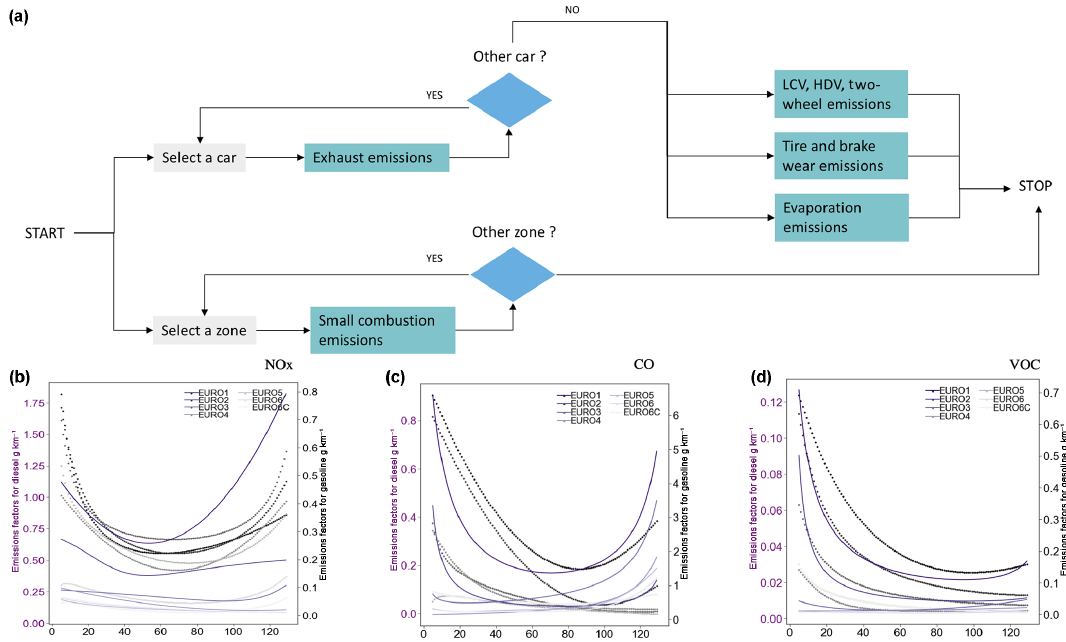
Figure 9. (a) Greenhouse gas and air pollutant emissions module (VULCAN) flow diagram; (b) , (c) and (d) represent NO x , CO and NMVOC emissions factors from diesel and gasoline passenger